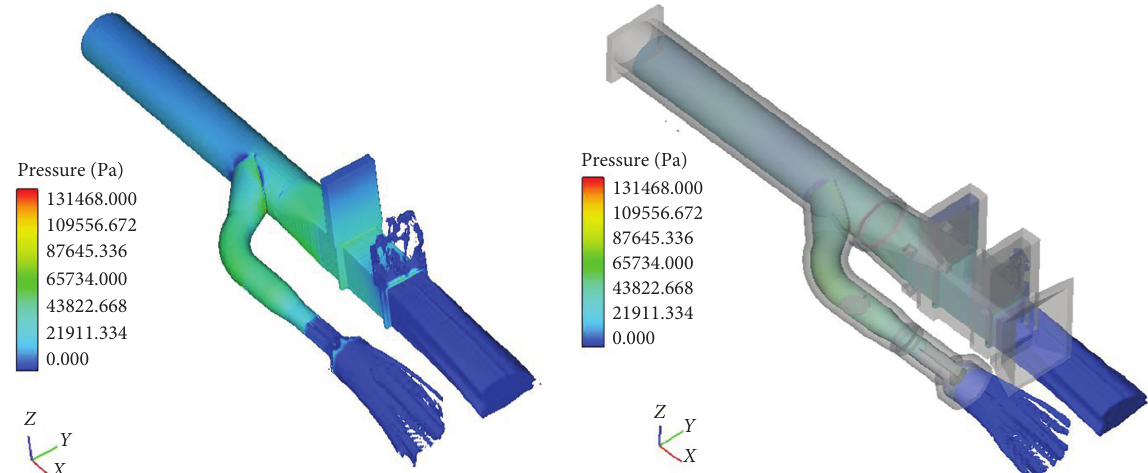
Figure 18: Three-dimensional view of the pressure in the whole model.